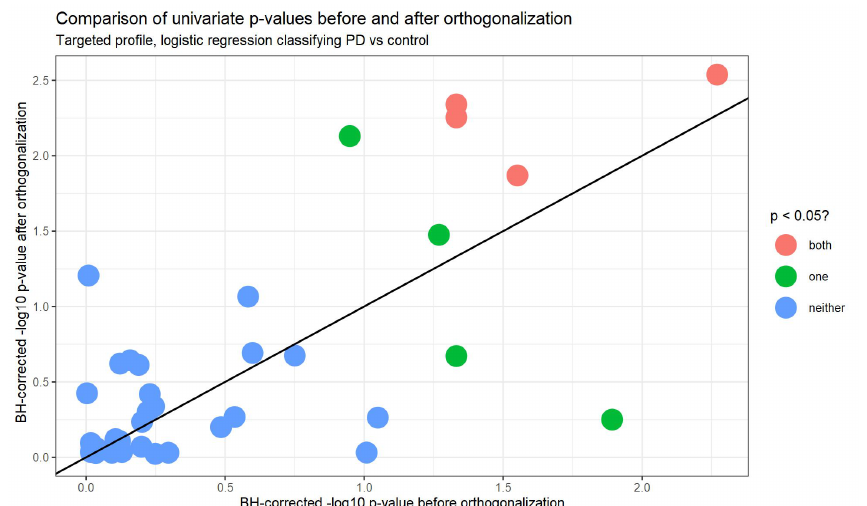
Figure A8. Comparison of univariate p -values before and after orthogonalization, using univariate logistic regressions fit on the targeted profile to classify PD against controls. p -values are Benjamini– Hochberg corrected within each dataset, with a − log transformation applied. The y = x line 10 is also drawn, with values above the line representing metabolites which are more differentially abundant after orthogonalization. Points are colored according to false discovery rate cutoffs of 0.05, indicating whether a metabolite is considered differentially abundant in both analyses, only one analysis, or in neither